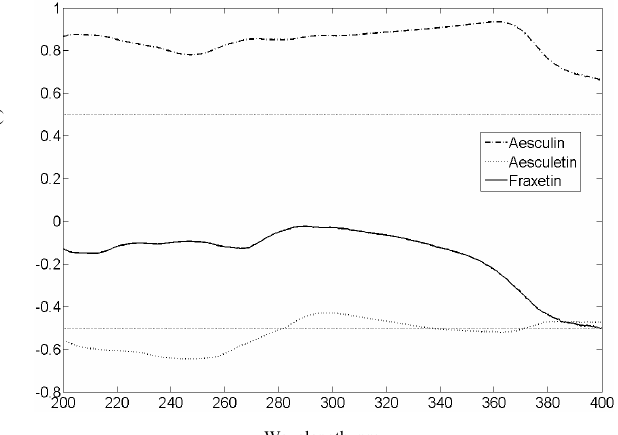
Figure 2. The UV spectra of the extract solutions of Cortex fraxini